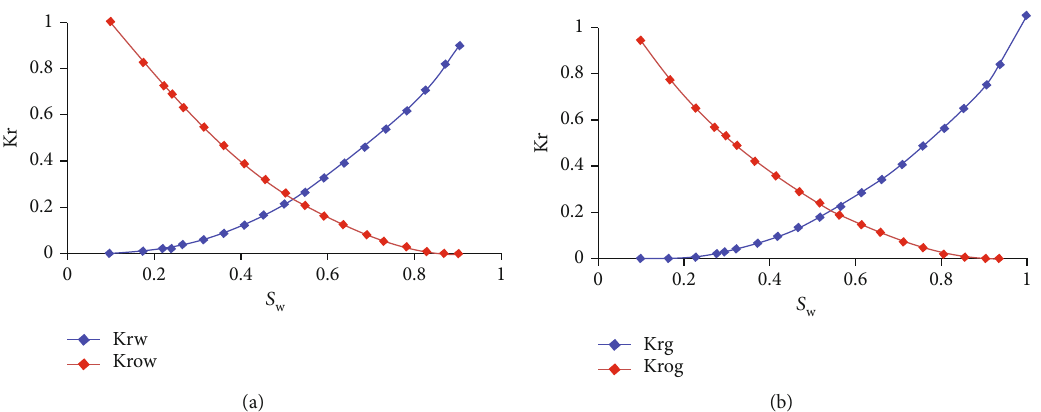
) and oil ( K ) and (b) two-phase gas ( K ) rw row rg